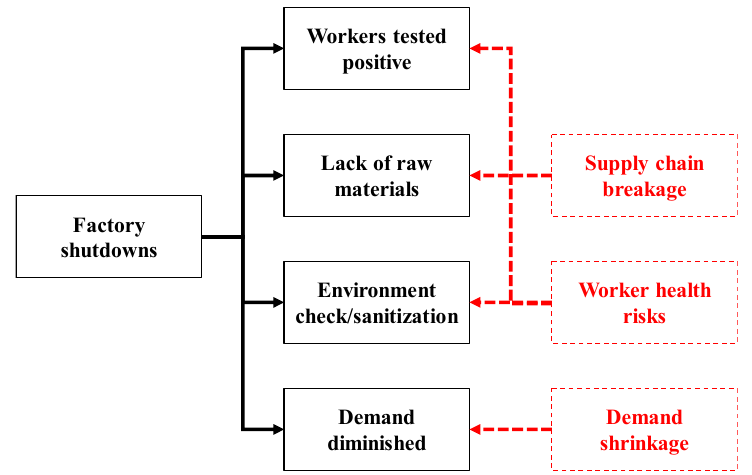
Figure 2. Four types of factory shutdowns amid the COVID-19 pandemic (red parts indicating the causes of shutdowns).